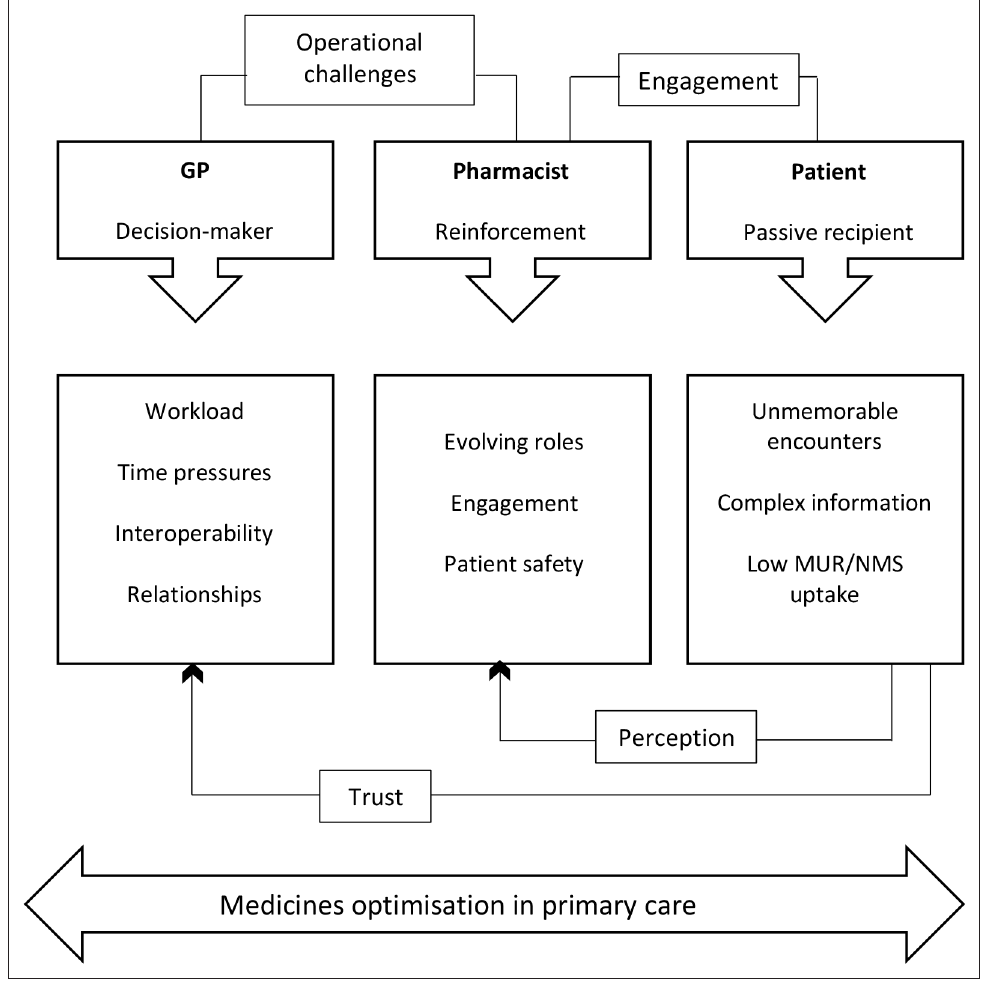
Figure 2 Emergent framework and the interplay between themes. NMS = New Medicine Service. MUR = Medicines Use